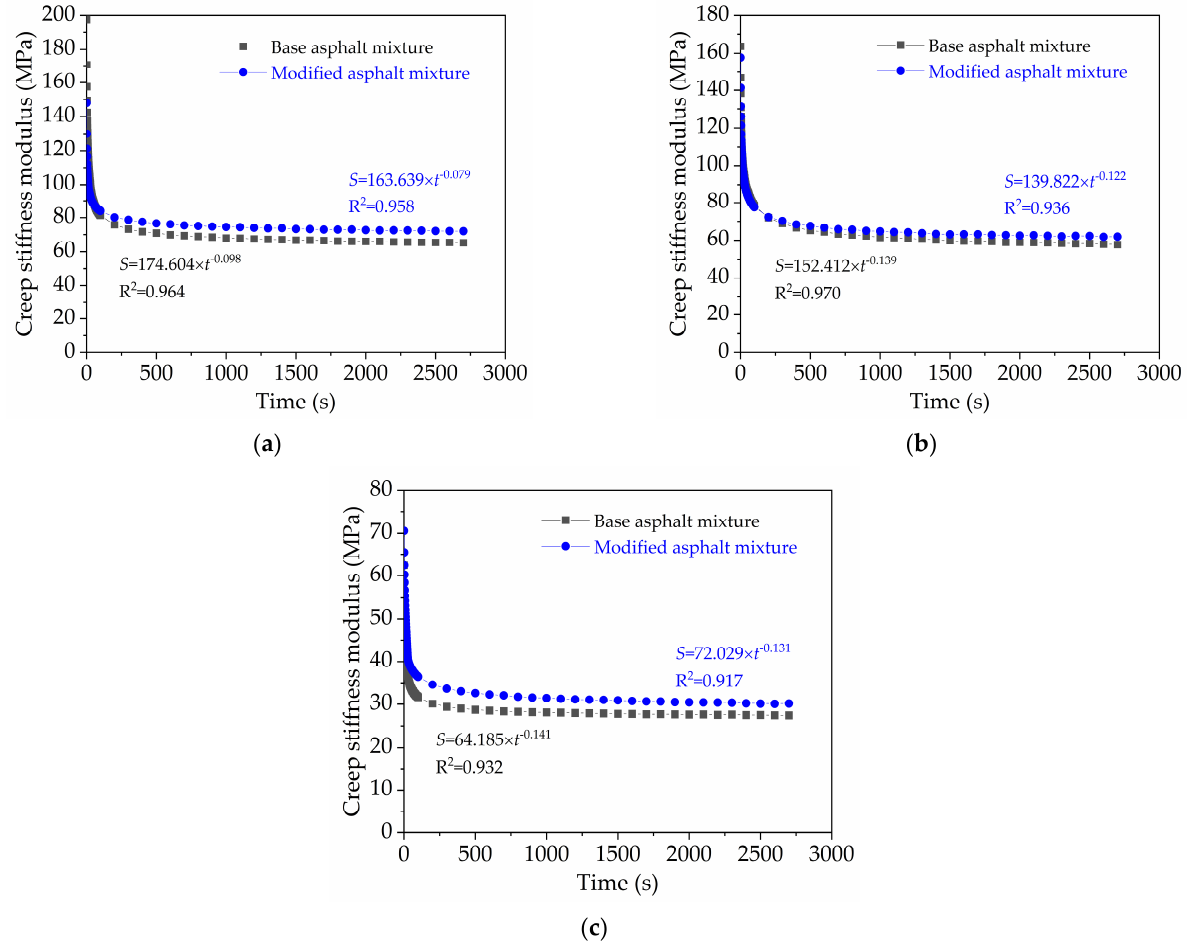
Figure 9. Creep stiffness modulus versus time for base bituminous mixture and nano-TiO 2 /CaCO 3 modified bituminous mixture: ( a ) 20 °C; ( b ) 35 °C; and ( c ) 50 °C.